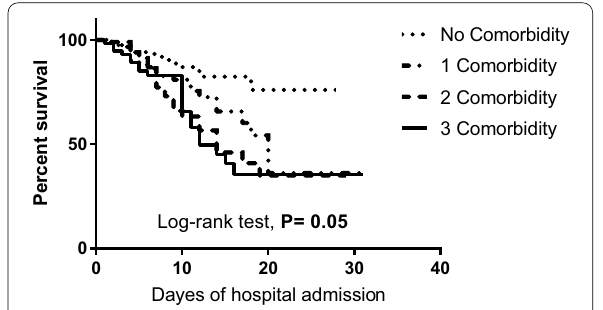
Fig. 4 Kaplan–Meier survival curve of COVID‑19 cases included in the study stratified according to number of comorbidities ( n